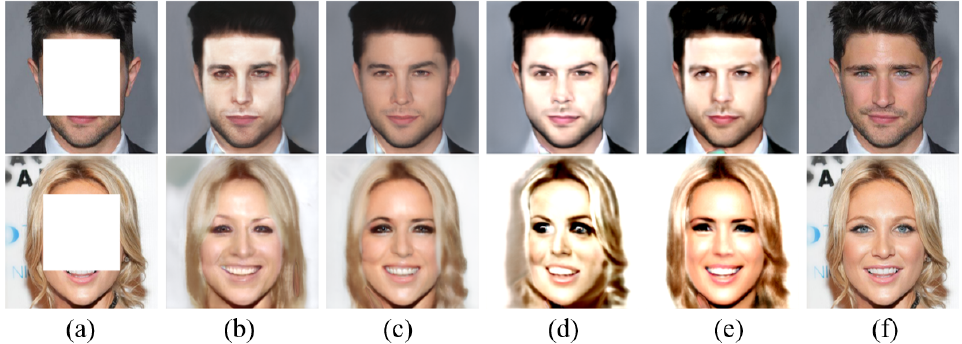
Figure 4. Comparison of completion results with different loss functions. ( a ) Masked images, ( b – e ) Inpainted results using L 2 , Log - Cosh , SSIM , MS - SSIM losses, respectively. ( f ) Original